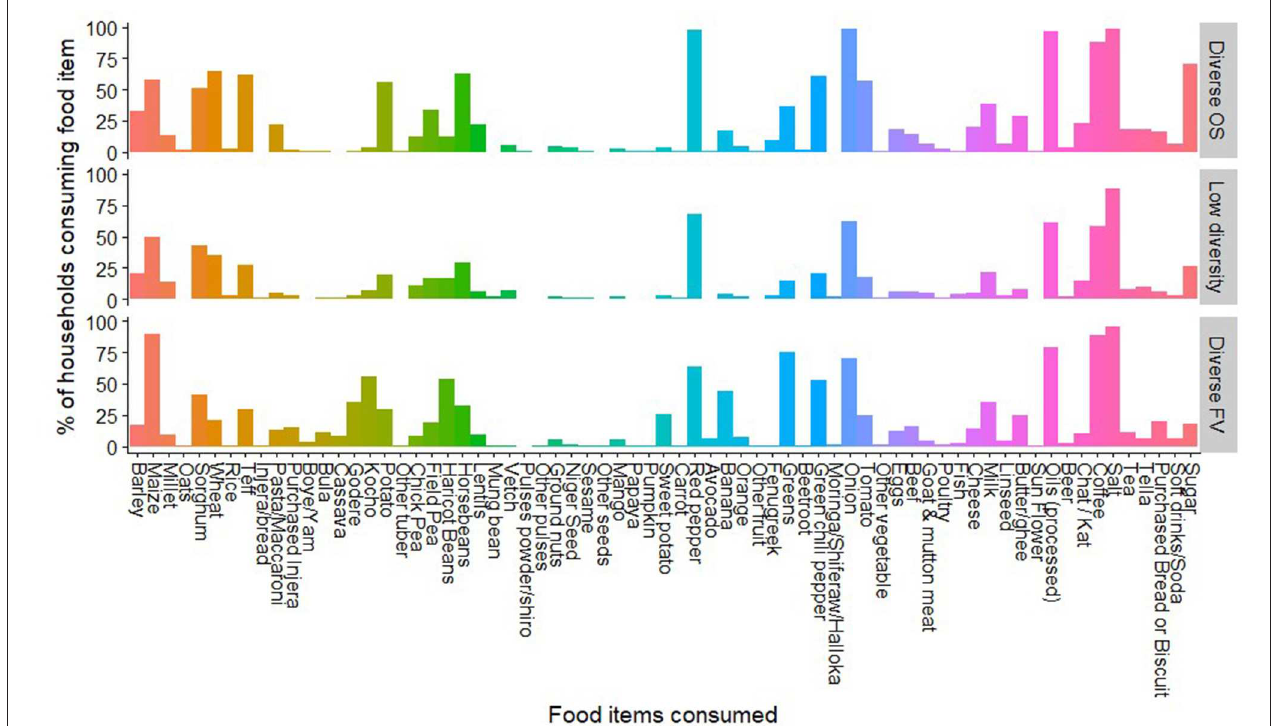
FIGURE 1 | Percentage of households reporting the consumption of various food items within the past 7 days for each of the three identified Dietary Profiles. N = 2367 rural households. OS, Oils and Sugars; FV, Fruits and Vegetables.